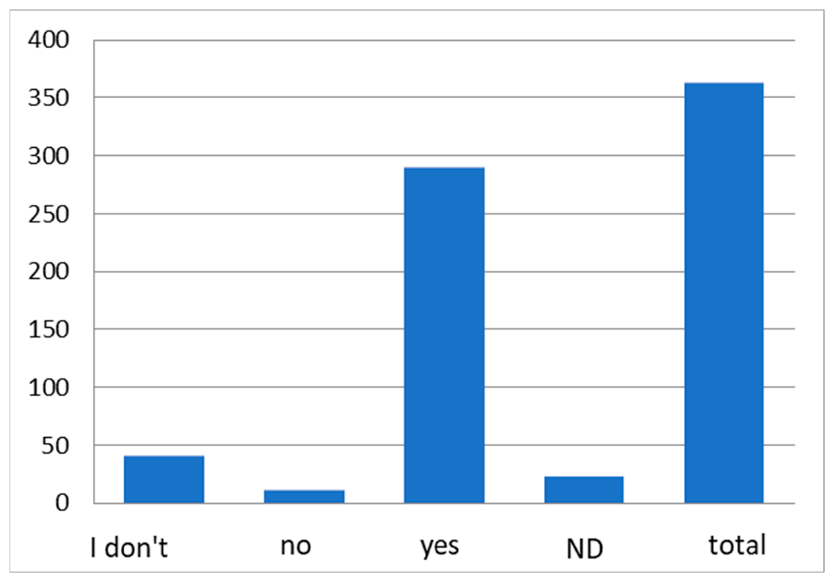
Figure 1. Being guided by values in undertaking innovative activities by ZGM TBS Sp. z assuming the analysed sample ( n = 362).